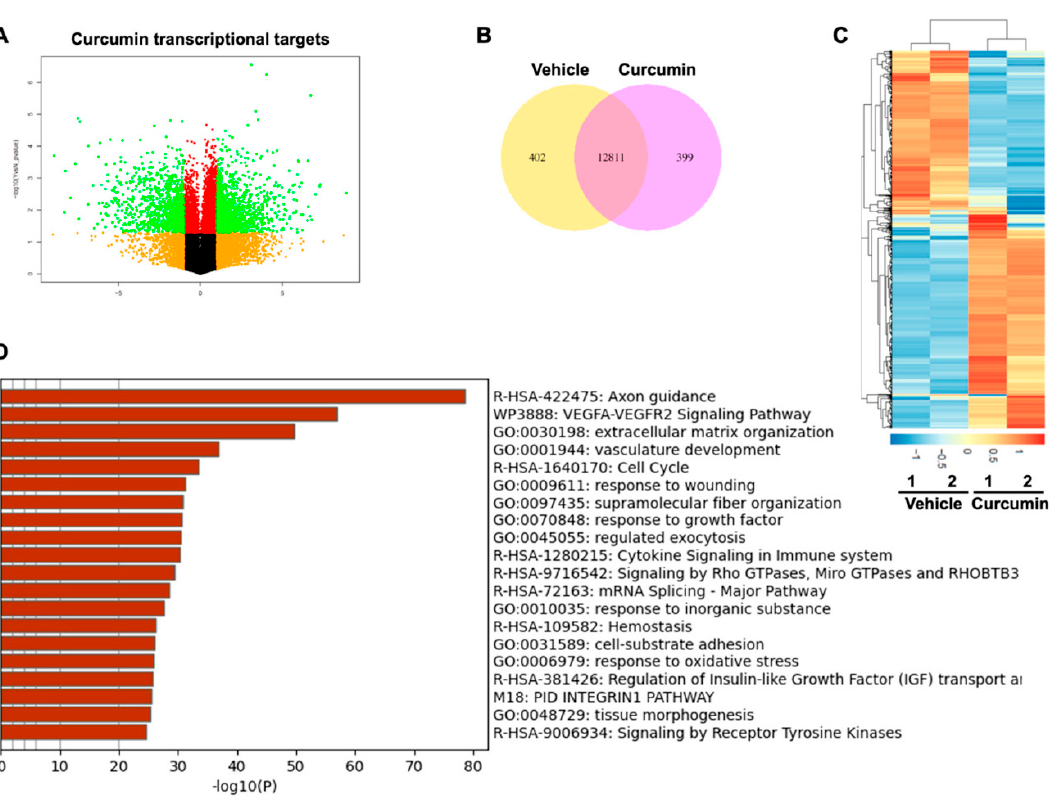
Figure 1. Transcriptome analysis of PDLSC with curcumin treatment. ( A ) Volcano plot showing the log2 fold changes of curcumin target gene expression with 5 μ M curcumin treatment on the x -axis and the statistical p -value on the y -axis. ( B ) Venn diagram of differentially expressed genes in curcumin treated PDLSCs with p < 0.05. Vehicle: upregulated transcripts with vehicle treatment. Curcumin: upregulated transcripts with curcumin treatment. ( C ) Heat map of RNA-seq analysis data showing the differentially regulated genes with curcumin treatment. Gene expression is shown in normalized log2 counts per million. Differentially expressed genes were selected based on the fold change. ( D ) Enrichment analysis of Gene Ontology (GO) for differentially regulated curcumin target genes. Only the top 20 false discovery rate (FDR) enrichment of GO terms from “biological process” category were listed.